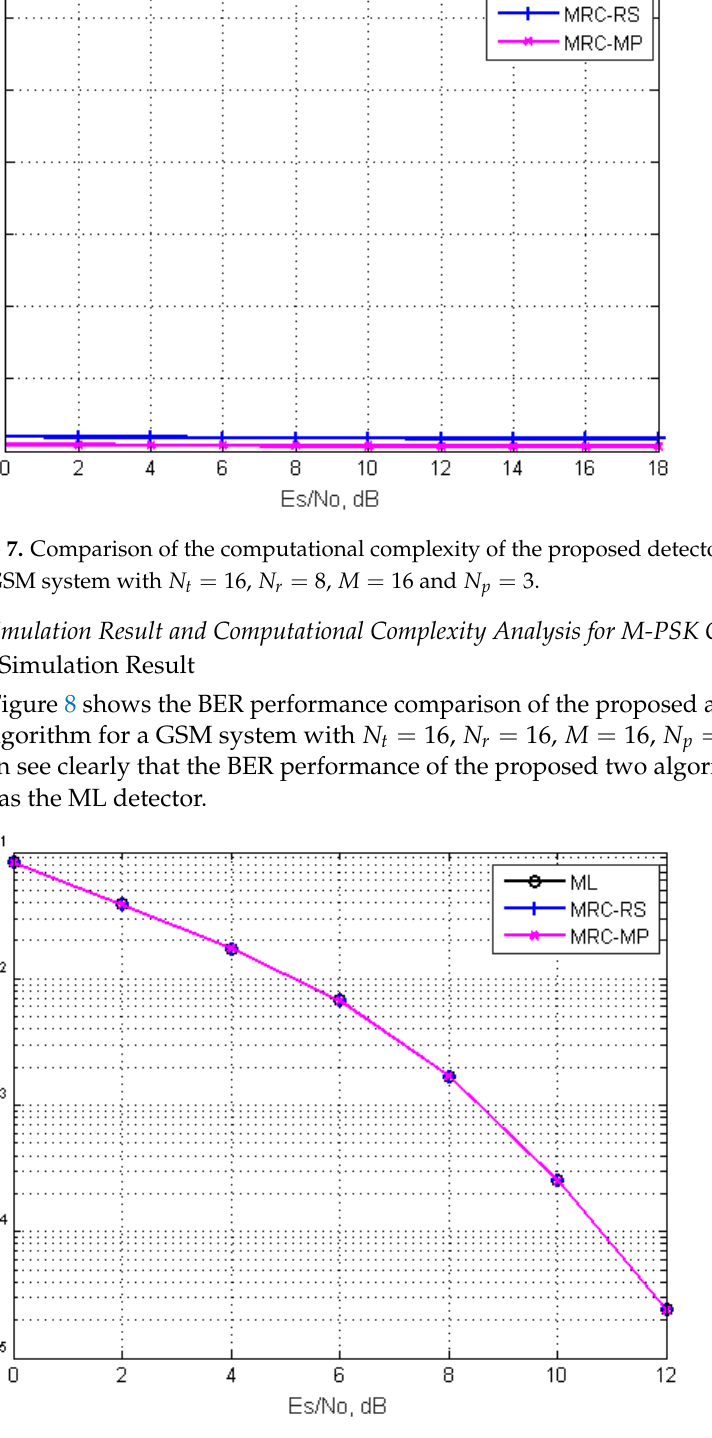
Figure 6. Comparison of the computational complexity of the proposed detectors and ML detectors for a GSM system with